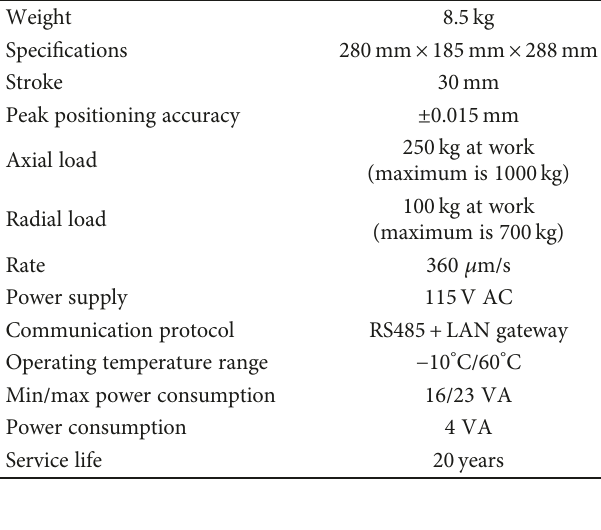
Table 7: Design parameter speci fi cations of SRT actuators.